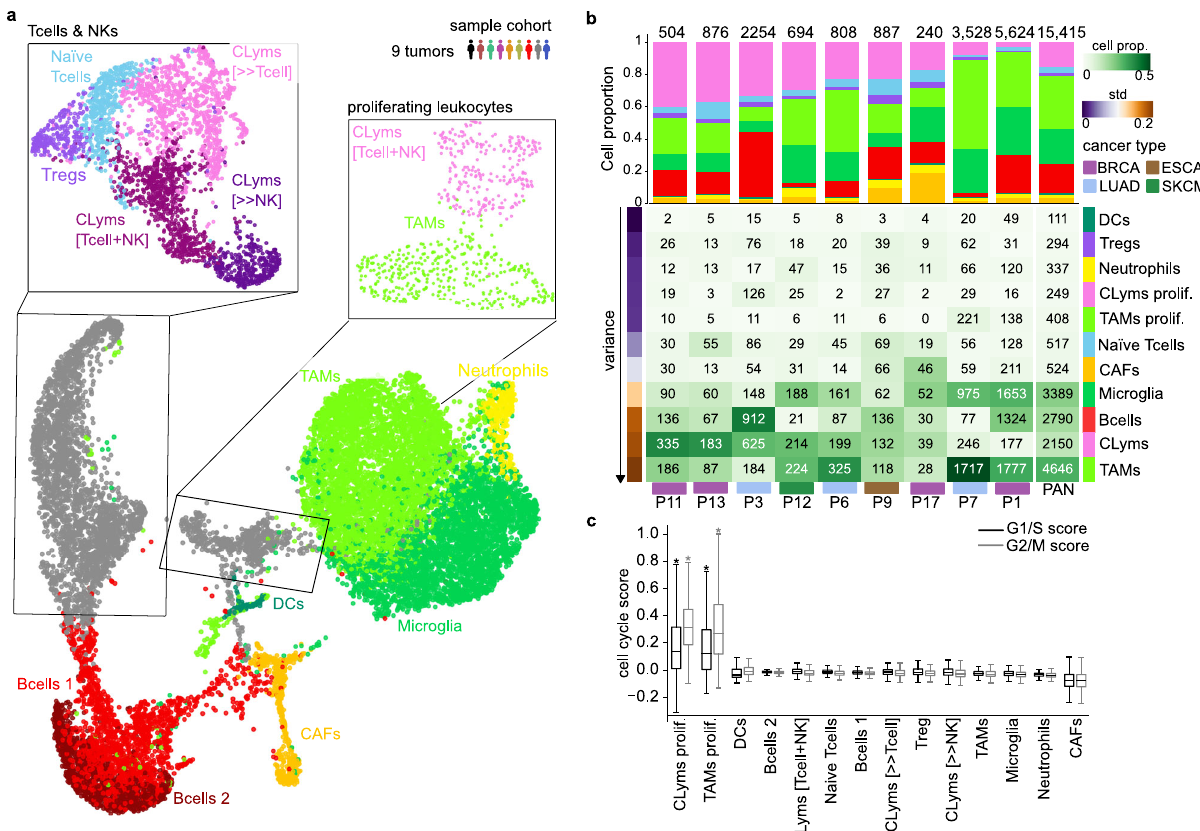
Fig. 2 High-resolution map of immune in fi ltration of brain metastases. a UMAP projection of tumor-in fi ltrating cells colored according to cell lineages ( n = 9 patients, n = 9 tumor samples, n = 15,415 cells). On top right, a diagram representation of the sample cohort considered for all fi gure panels is shown. A detailed UMAP projection is shown for T cell and NK and proliferating leukocyte cell clusters. Cytotoxic lymphocyte (CLym), cancer-associated fi broblast (CAF), tumor-associated macrophage (TAM), T cell regulatory (Treg), dendritic (DC), natural killer (NK). b Heatmap showing the relative abundance of tumor-in fi ltrating cell type, measured as the proportion of cells of the cell type vs. the total of sequenced cells, across tumor samples in